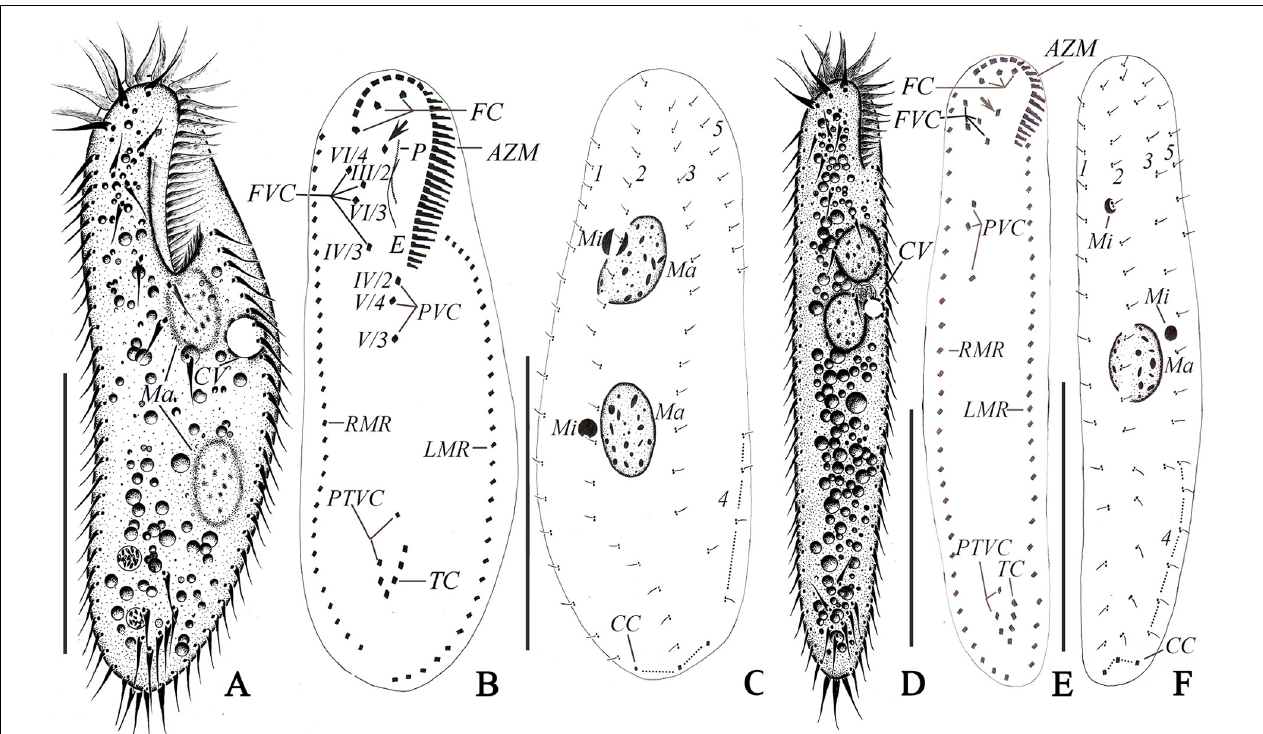
FIGURE 1 | Morphology of normal (A–C) and abnormal (D–F) forms of Oxytricha granulifera granulifera in vivo (A,D) and after protargol staining (B,C,E,F) . (A) Ventral view of a representative normal individual. (B,C) Ventral (B) and dorsal (C) views of a typical specimen to show ciliature and nuclear apparatus, arrow in (B) marks the buccal cirrus. (D) Ventral view of a representative abnormal cell. (E,F) Ventral (E) and dorsal (F) views of an abnormal cell, arrow in (F) marks the buccal cirrus. AZM, adoral zone of membranelles; CC, caudal cirri; CV, contractile vacuole; E, endoral; FC, frontal cirri; LMR, left marginal row; FVC, frontoventral cirri (III/2, IV/3, VI/3, and VI/4); Ma, macronuclear nodules; Mi, micronuclei; P, paroral; PTVC, pretransverse ventral cirri; PVC, postoral ventral cirri (IV/2, V/3, and V/4); RMC, right marginal cirri row; TC, transverse cirri. 1–5, dorsal kineties 1–5. Scale bars = 50 µ